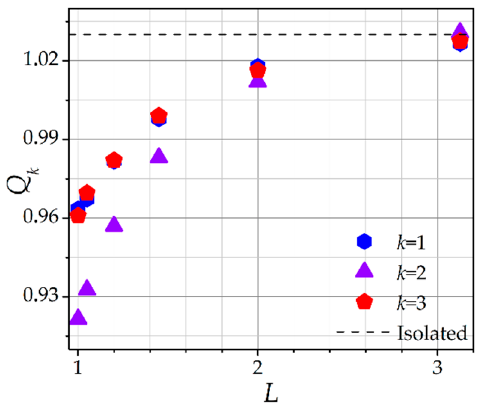
Figure 4. Dependence of the self-consistent dust particle charge Q k on the self-consistent interparticle distance L . l i = 5, E = 0.